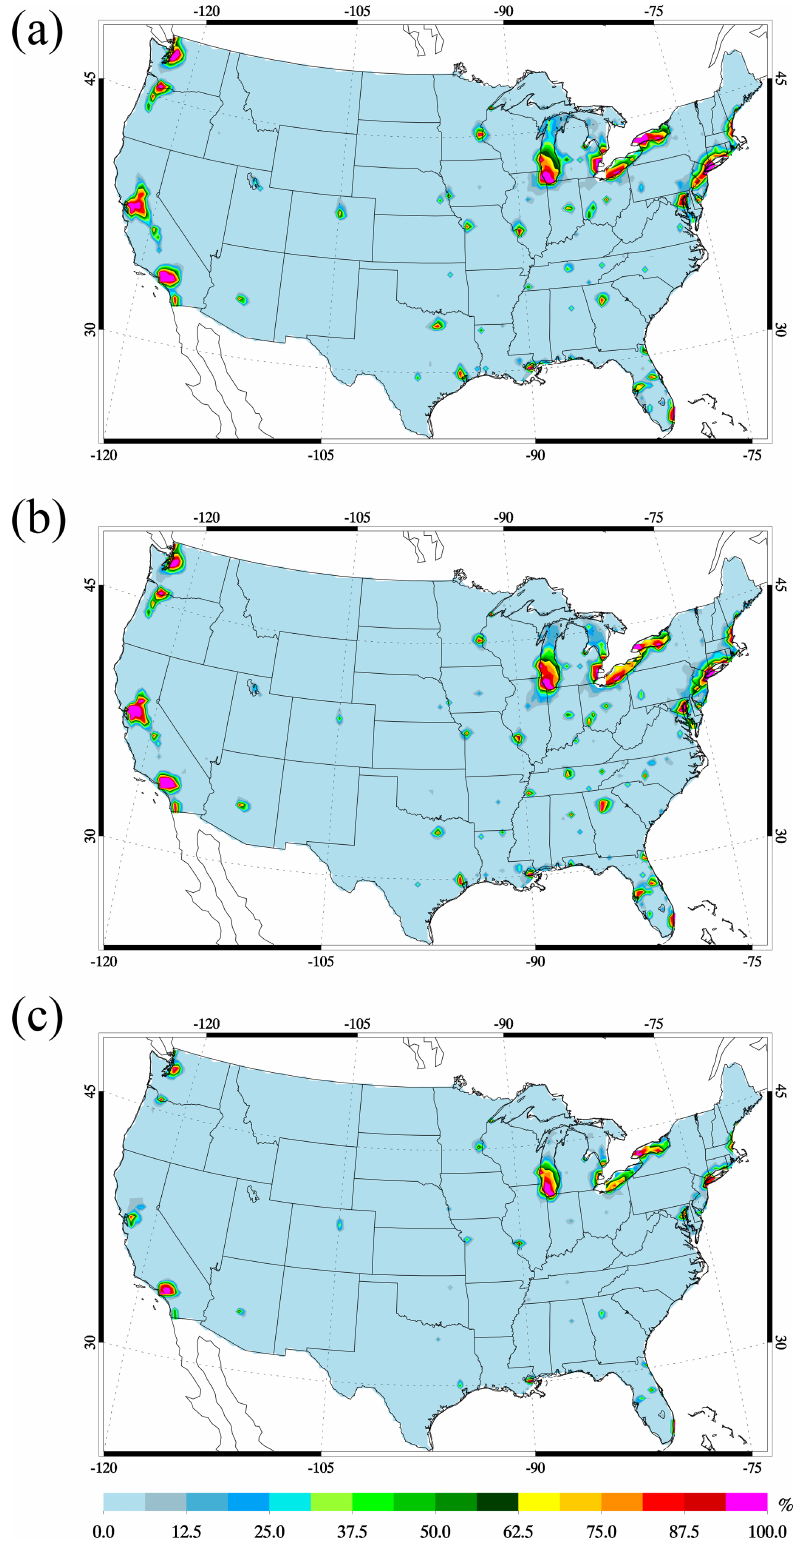
Figure 10. Probability of VOC-sensitive photochemical ozone production (i.e., O 3 / NO y < 15) in the CONUS simulated by CMAQ at 14:00LT in July of (a) 1995, (b) 2005 and (c)